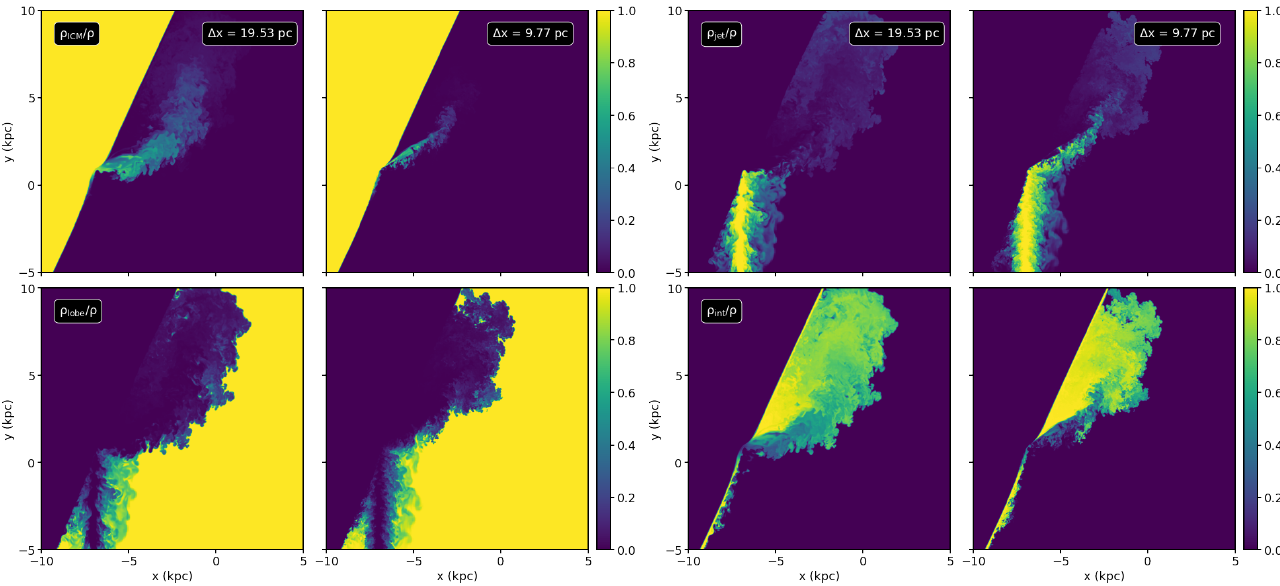
Figure A2. Comparison of the fiducial simulation at two different spatial resolutions at t = 125 kyr. Panels show slices through the center of the simulation domain of the four different mass scalars. Each panel is 15 kpc on a side, zoomed in slightly to focus on the parts of the simulation most affected by the